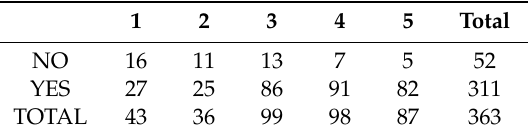
Table 4. Relevance of the cost of publication in choosing the journal (1 to 5), compared with the reduction of Open Access fees as an incentive measure (YES / NO).